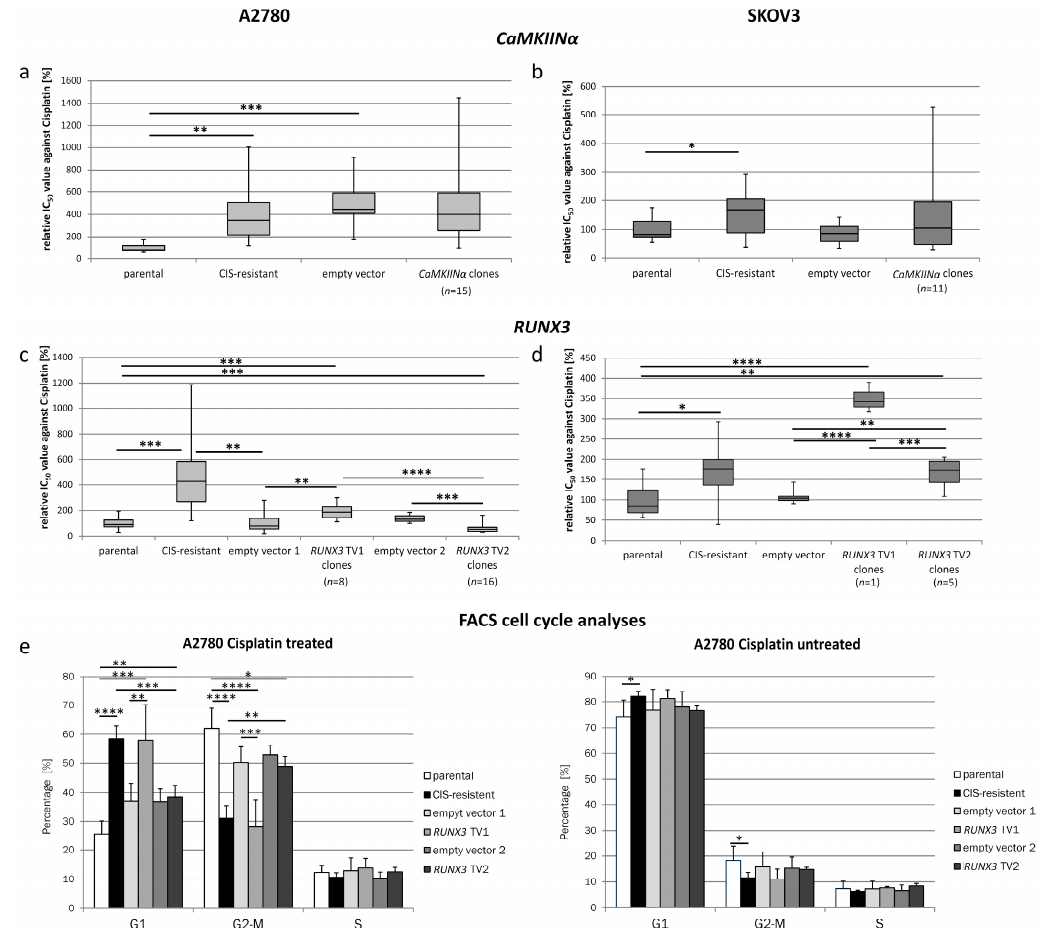
Figure 2. Sensitivity of the transgene expressing cells towards cisplatin. ( a ) IC 50 measurements of A2780-CIS cells overexpressing CaMKIIN α . The resistant A2780-CIS cells and the empty vector control presented the expected increased resistance towards cisplatin compared to parental A2780 cells. No significant change of IC 50 values was observed when CaMKIIN α was overexpressed in A2780-CIS; ( b ) In SKOV3-CIS cells the overexpression of CaMKIIN α as well resulted in unchanged cisplatin sensitivity; ( c ) IC 50 measurements of parental A2780 cells overexpressing RUNX3 in its two transcript variants. A2780 single cell clones expressing RUNX3 TV1 showed a significantly increased cisplatin resistance compared to the empty vector control and the parental cells but did not reach the resistance level of A2780-CIS cells. In contrast the A2780 RUNX3 TV2 single cell clones presented a significantly increased sensitivity. When comparing the A2780 clones expressing RUNX3 TV1 and clones expressing RUNX3 TV2, the difference in sensitivity was highly significant; ( d ) SKOV3 cells expressing RUNX3 TV1 exhibited a strong increase in cisplatin resistance while TV2 led to a slight increase, only. The difference between the cells expressing the two variants was significant; ( e ) Cell cycle analysis of A2780 cells revealed a significantly reduced G2/M arrest in cisplatin treated cells overexpressing RUNX3 TV1, resembling resistant A2780 subcultures. Mean values are shown for different RUNX3 overexpressing clones ( n = 4). For all subfigures: * p < 0.05, ** p < 0.01, *** p < 0.001, **** p < 0.0001. (Boxplots depict minimum and maximum values (whiskers); the inter quartile range (box) and the median (line). Bar charts depict the mean ±